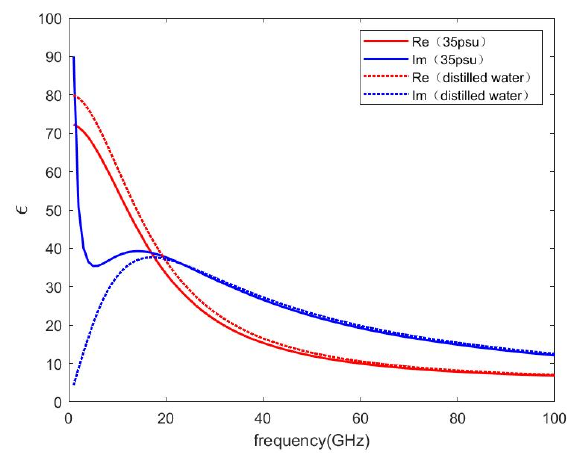
Figure 1. The permittivity of seawater varies with frequency. The red lines are for fresh water, and the blue lines are for salt water. The solid lines represent the real parts of the permittivity and the dotted lines represent imaginary parts. The water temperature T = 20 ◦ C. The salinity S = 35 psu.